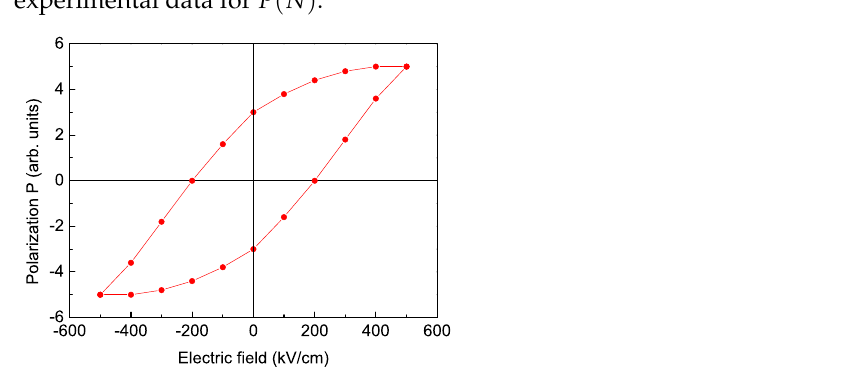
Figure 4: (Color online) The spontaneous magnetization M s as a function of the doping concentration of a (1) Co-doped (with J d = 1 . 4 J b ), (2) Er-doped (with J d = 1 . 2 J b ) and (3) Ti-doped (with J d = 0 . 8 J b ) YFO nanoparticle for T = 300 K and N = 10 shells.